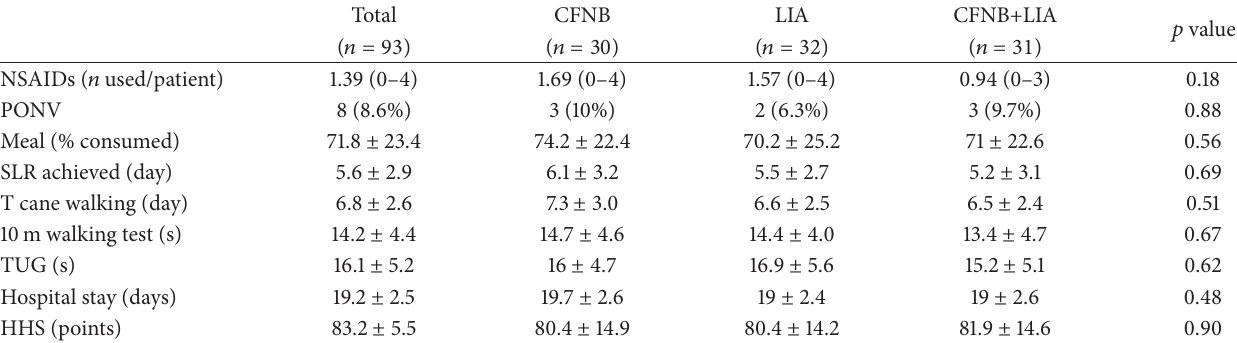
Table 2: Overall comparison of